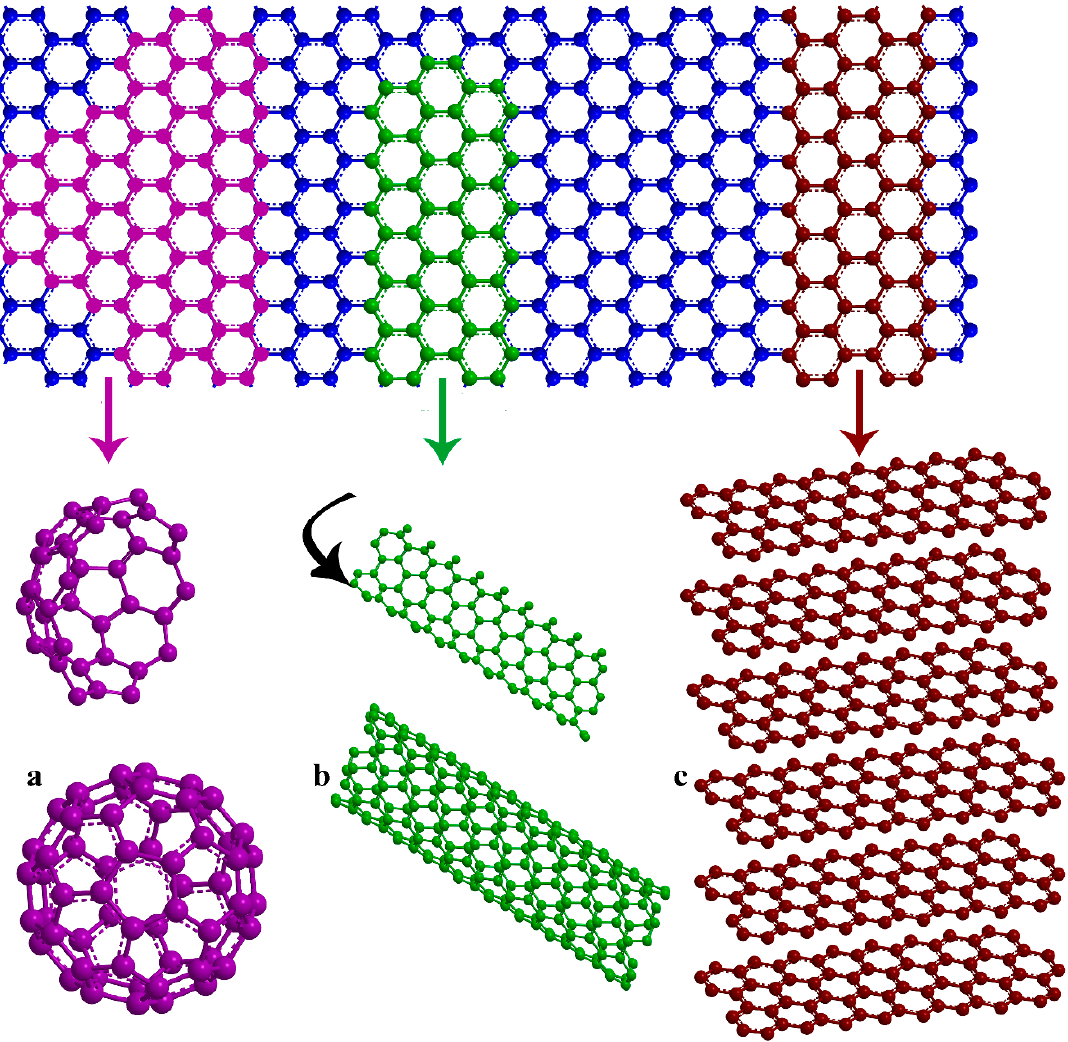
Figure 2. 2D Graphene nanosheets as the basic building units of various carbon allotropes ( a ) 0D, ( b ) 1D, and ( c ) 3D.